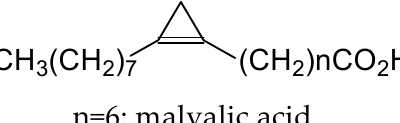
Figure 1. Sterculic and malvalic acid chain structure.